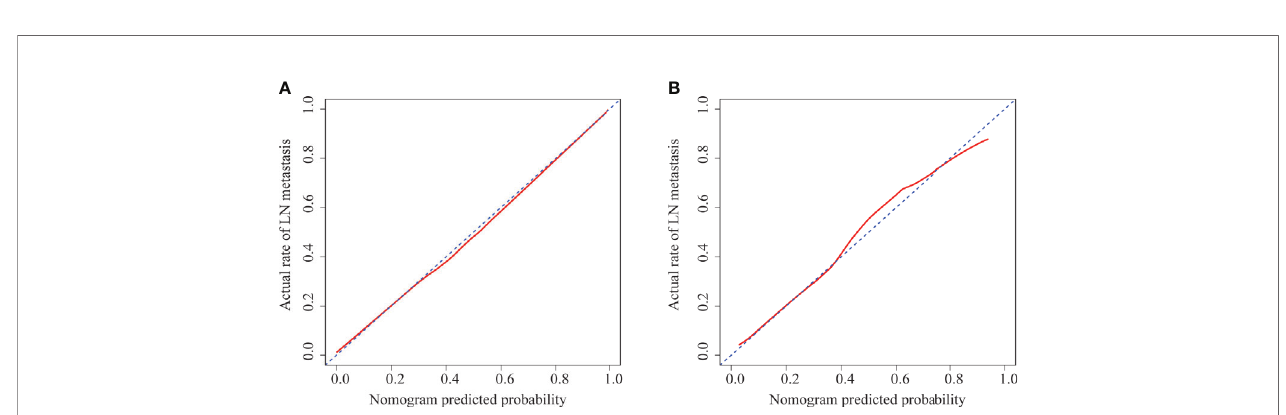
FIGURE 6 | Calibration curves of radiomics nomogram in each cohort. (A) The calibration curve of radiomics nomogram in the training cohort. (B) The calibration curve of radiomics nomogram in the validation cohort. The x-axis represented the predicted LN metastasis risk. The y-axis represented the actual LN metastasis rate. The diagonal blue line represented a perfect prediction by an ideal model. The red line represented the performance of the radiomics nomogram, of which a closer fi t to the diagonal blue line represented a better